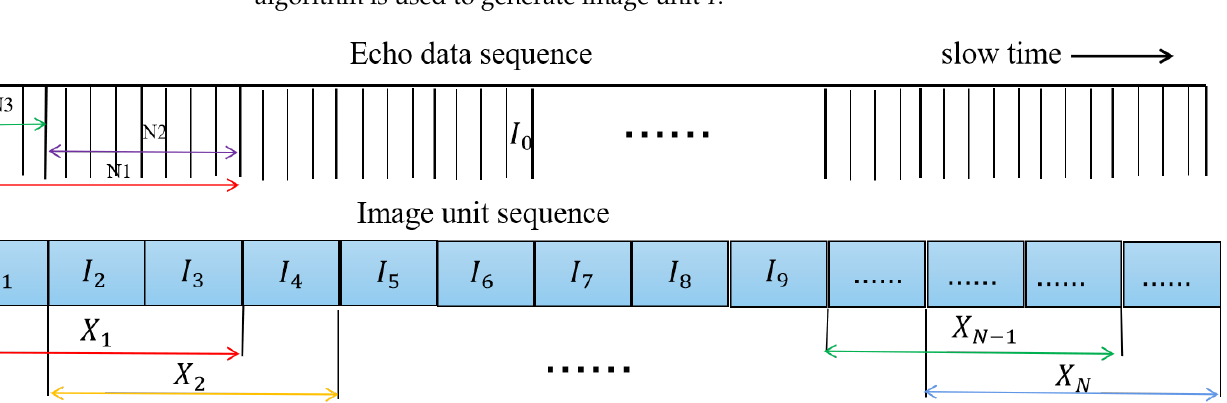
where I 0 denotes an echo pulse and Θ represents the BP imaging